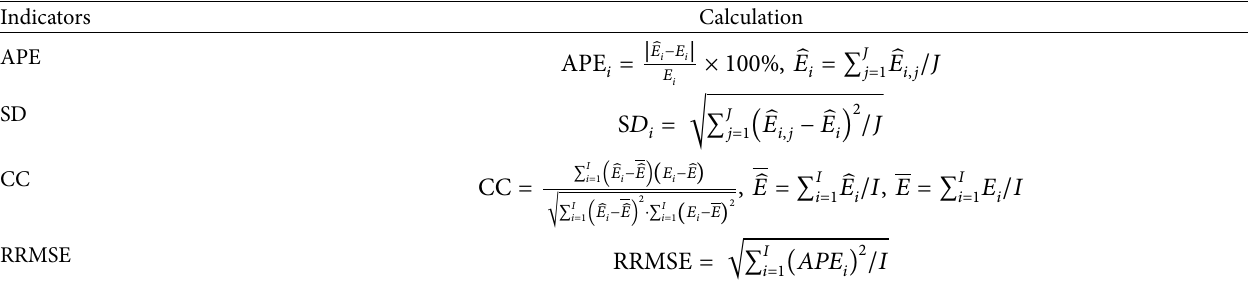
Table 4: Evaluation indicators and their